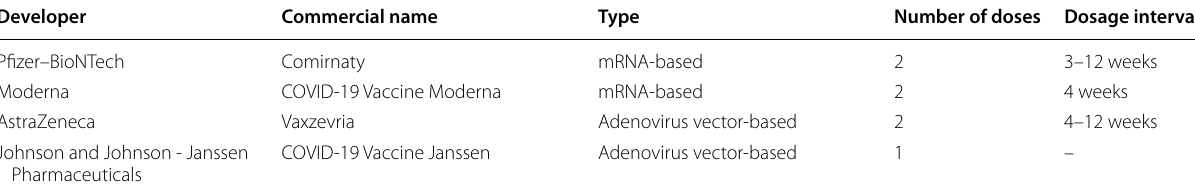
Table 1 Main characteristics of the four COVID‑19 vaccines approved in Europe as of July 28, 2021